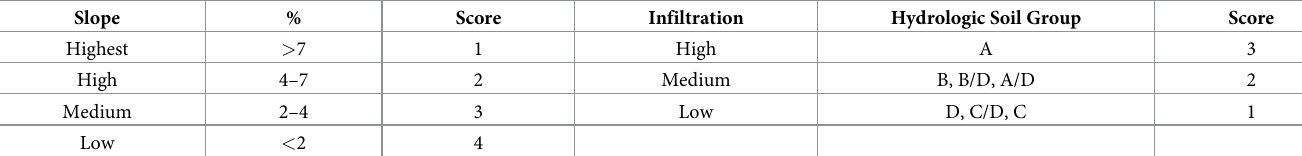
Table 1. Scores used to define reforestation priorities, based on slope and hydrologic soil